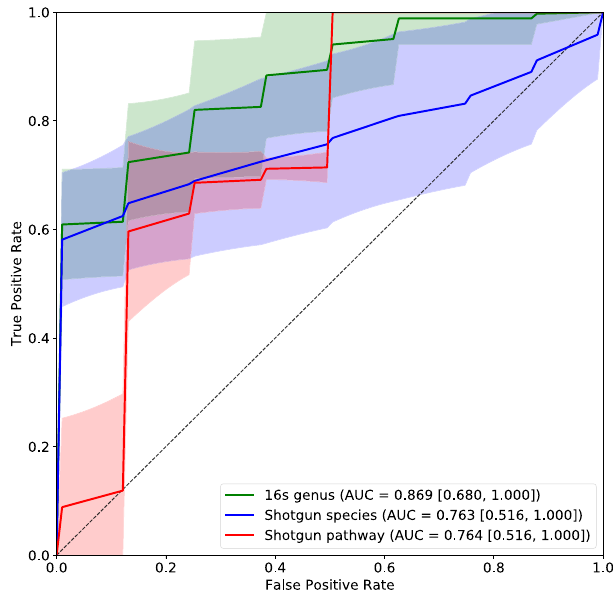
Figure 6. Validation ROC curves based on the random forests models with 500 trees developed from the training data. Numbers in the square brackets represent the 95% confidence interval of the AUROC